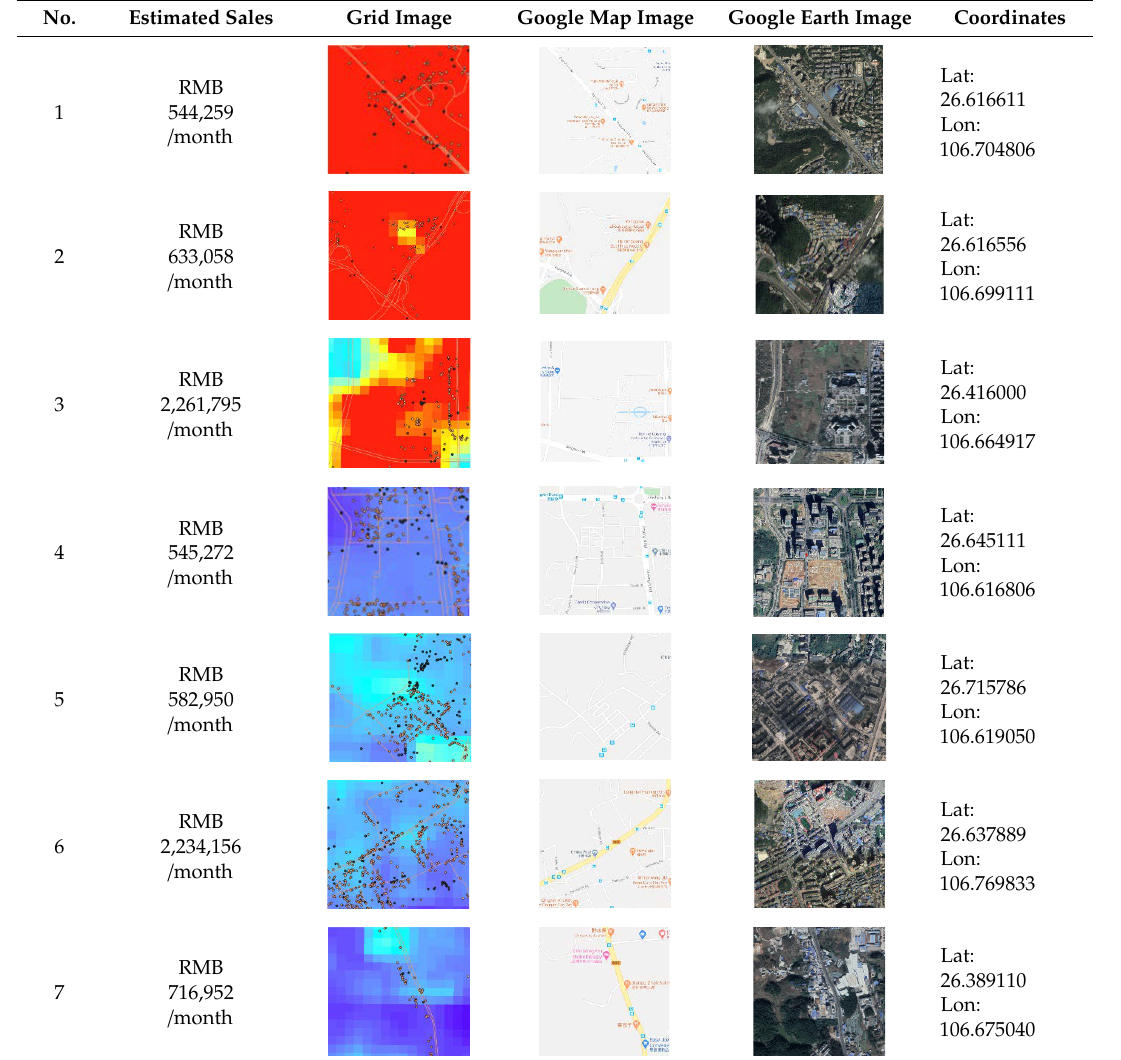
Figure 11. Eighteen recommended sites with high market potential. Table 6. Specific surroundings of samples in recommended sites.